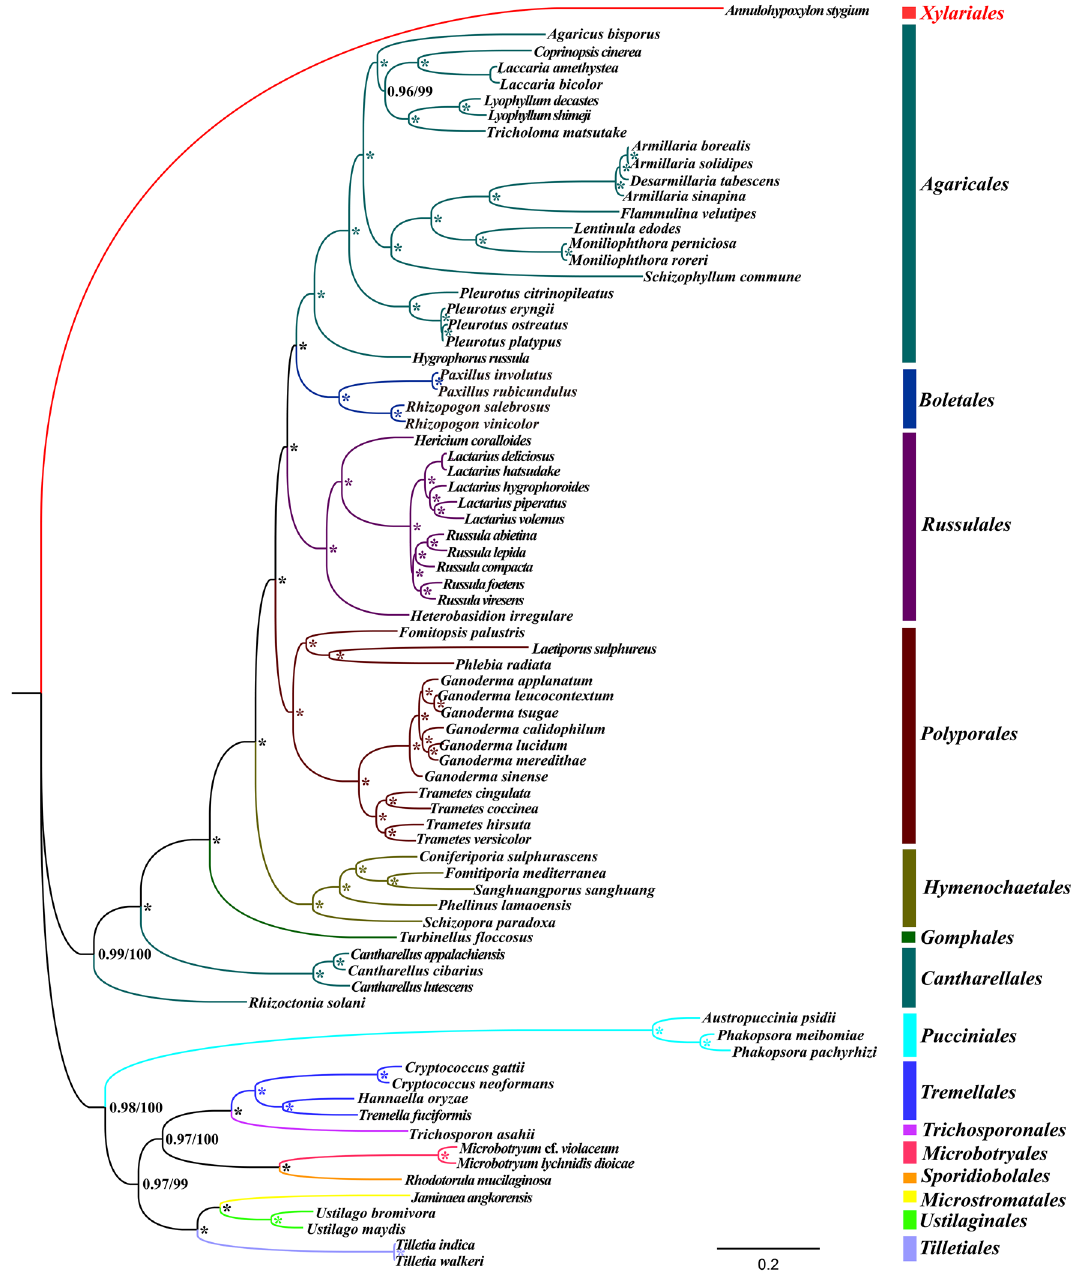
Figure 8. Phylogeny of 77 Basidiomycota species based on 15 protein coding genes and two rRNA genes using Bayesian inference (BI) and Maximum likelihood (ML) analysis. Support values are Bayesian posterior probabilities (before slash) and bootstrap (BS) values (after slash). The asterisk indicates that the BPP value is 1 and the BS value is 100 of the branch. Species and NCBI accession numbers for mitogenomes used in the phylogenetic analysis are provided in Supplementary Table